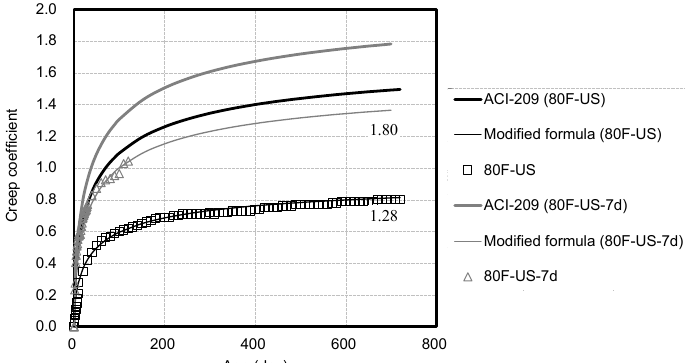
Figure 12. Comparison of compressive creep coefficients based on the age of loading of 28 days and 7 days .